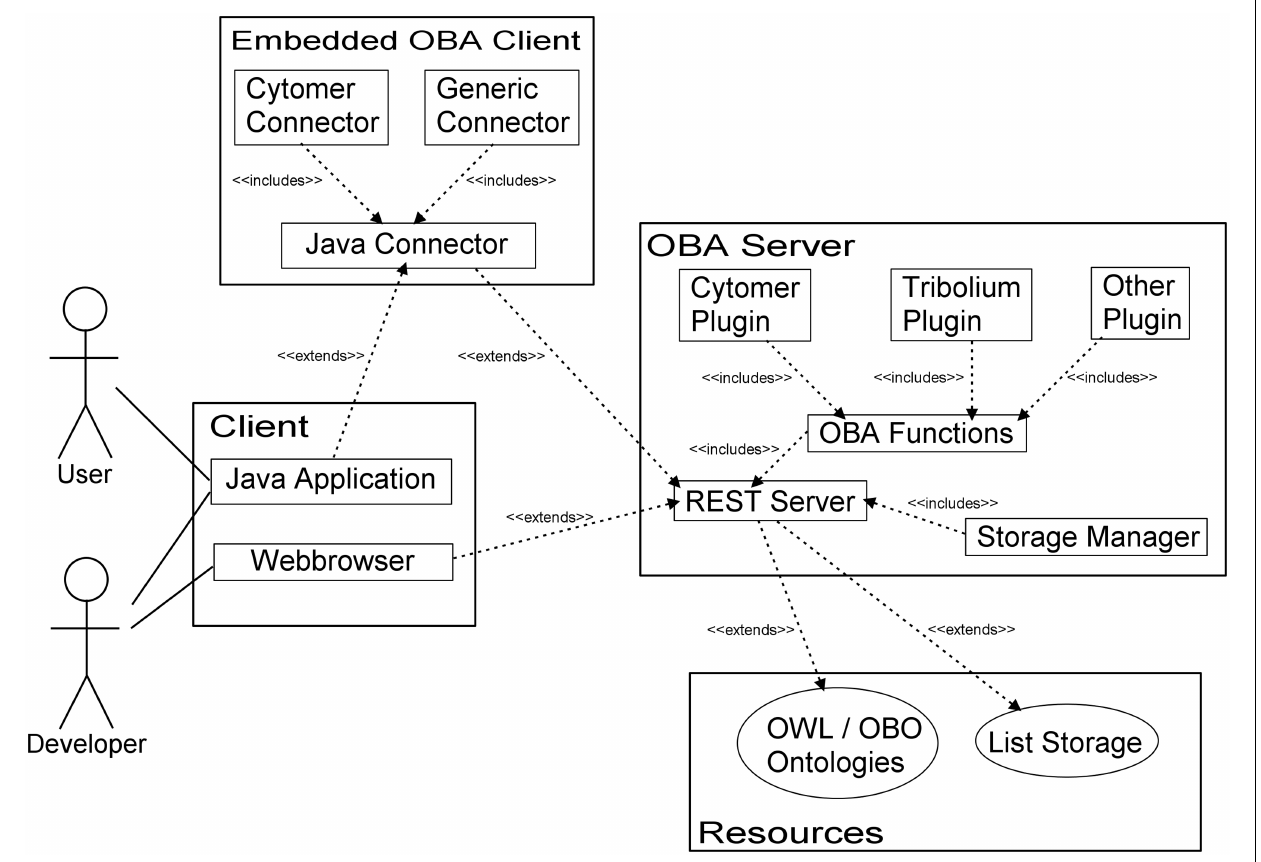
FIGURE 1 |The components of the OBA project and their relations. The components of the OBA project are displayed together with their connections to external parts, to ontology files or to other